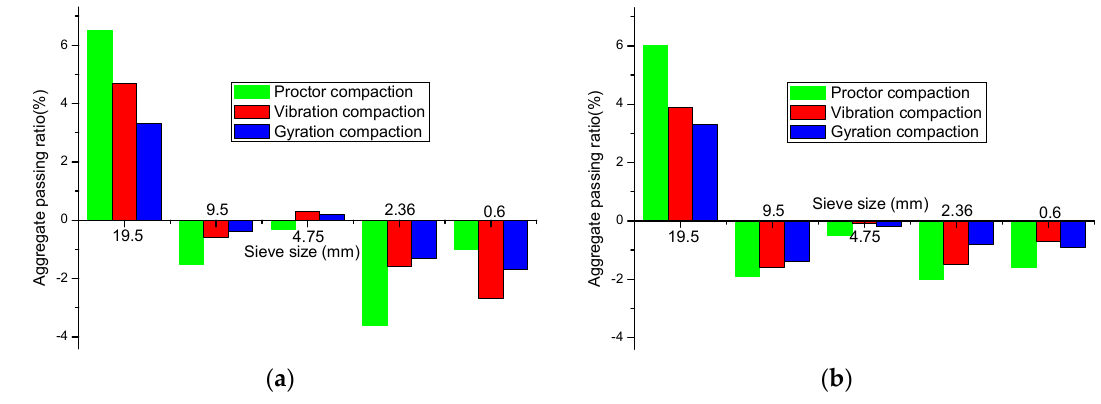
Figure 8. Schematic diagrams of aggregate degradation for ( a ) Aggregate A and ( b ) Aggregate B.